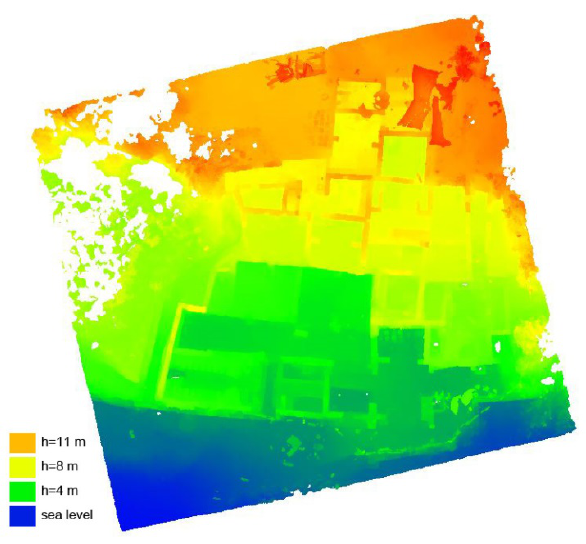
Figure 7. Height distribution of the site. targets, spherical and planar. The spherical targets (Figure